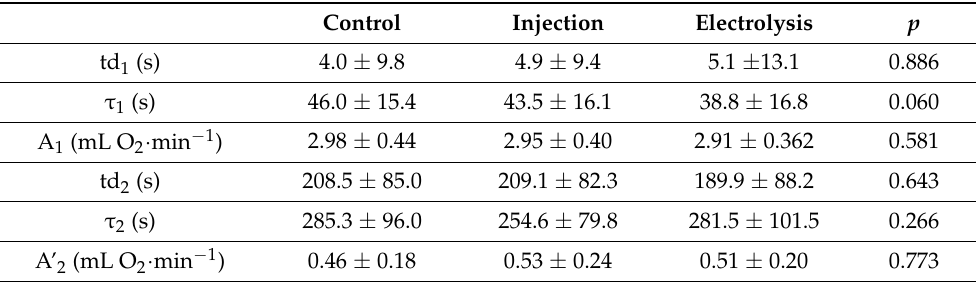
Table 3. Pulmonary VO 2 kinetics responses.